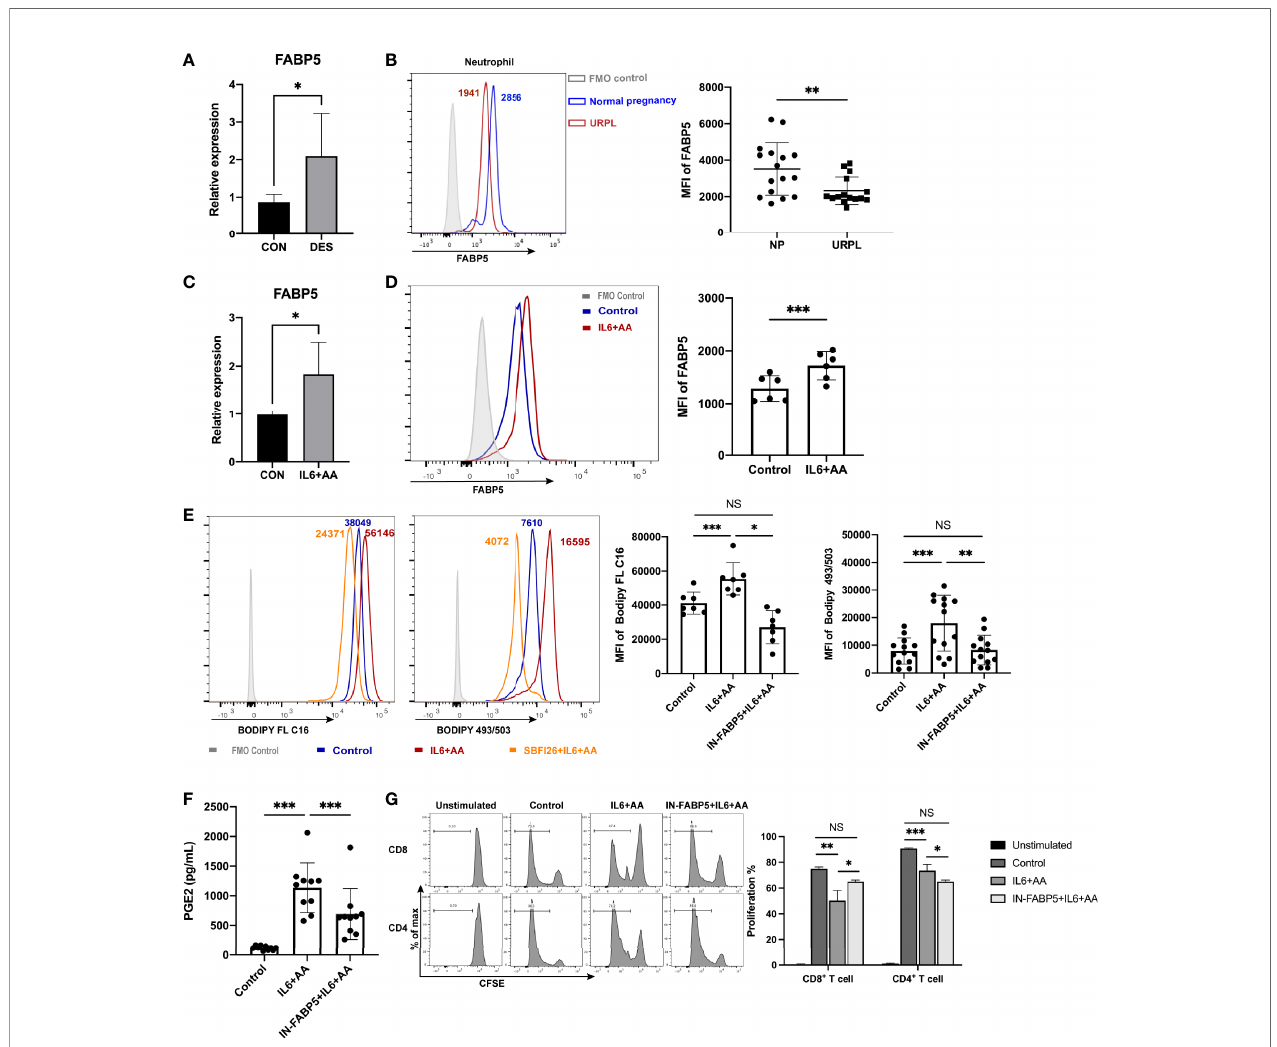
FIGURE 7 | FABP5 regulated arachidonic acid metabolism and the differentiation of PMN-MDSCs via fatty acid uptake and lipid accumulation. (A) The upregulation of FABP5 after DES treatment was veri fi ed by qRT-PCR (n = 5). (B) FABP5 expression in circulating neutrophils between NP (n = 16) and URPL patients (n = 15) was evaluated by fl ow cytometry. Upregulated FABP5 expression in neutrophils after stimulation with IL6 + AA was tested by qRT-PCR (n = 5) (C) and fl ow cytometry (n = 6) (D) (E) Representative fl ow cytometry and summarized data show decreased fatty acid uptake (n = 7) and lipid accumulation (n = 13) in circulating neutrophils after FABP5 blockade. (F) The secretion of PGE2 stimulated by IL6 + AA was inhibited by SBFI26 (n = 10). (G) CD4+ and CD8+ T-cell proliferation were restored by SBFI26 (n = 6). All data are represented as mean ± SD. Signi fi cance was determined by unpaired Student ’ s t-test or one-way ANOVA with Tukey ’ s post-hoc test. ***p < 0.001, **p < 0.01, *p < 0.05, NS, not signi fi cant. FMO, fl uorescent minus